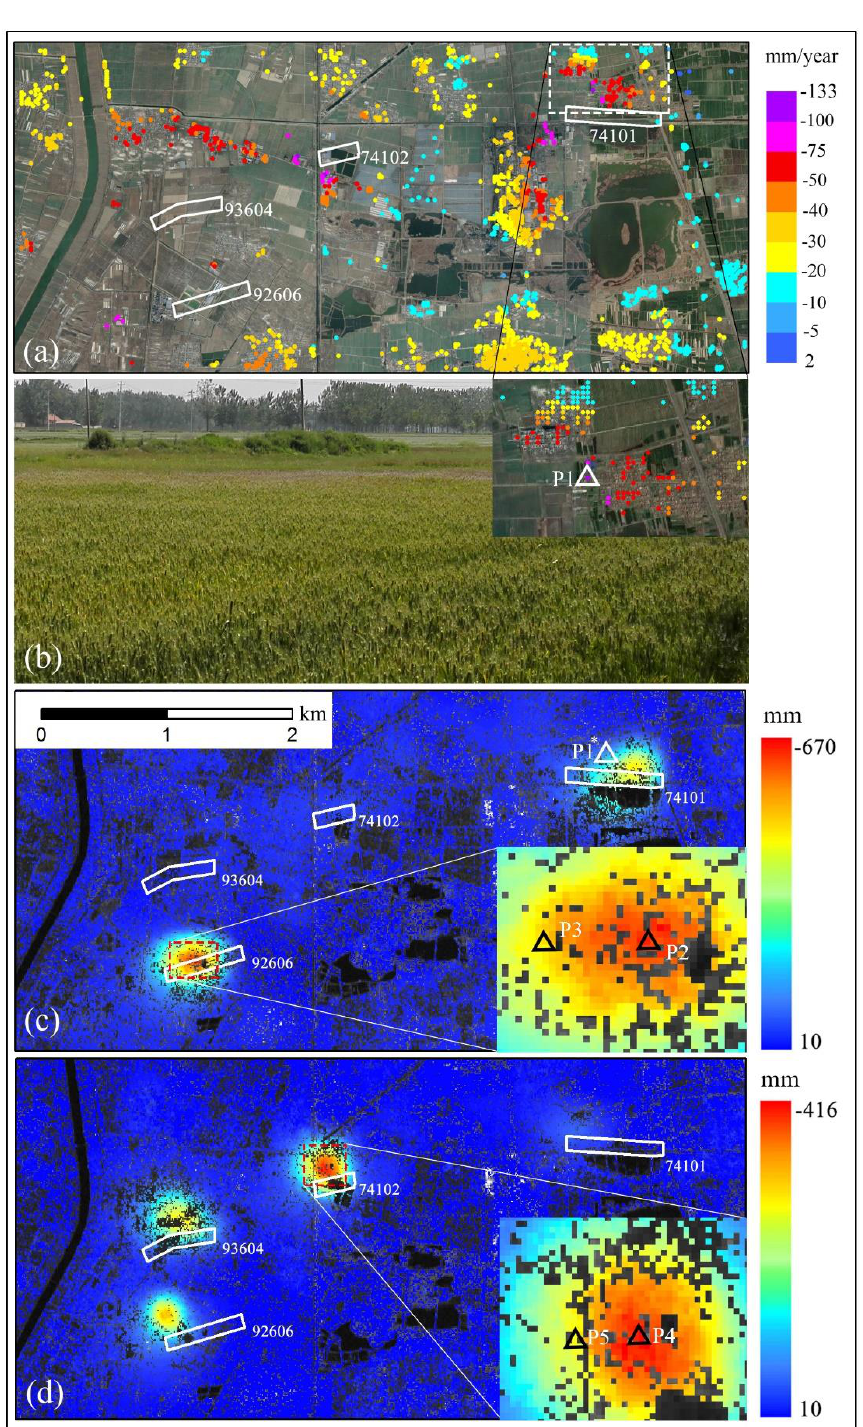
Figure 8. Enlargement of MSV over the rectangle AOI in Figure 7a is shown in ( a ) overlaid on an optical image. The extraction boundary of 4 WPs are also overlaid as white rectangles and polygons in ( a ). The location of a CP (P1) is delineated by the dash-line rectangle in ( a ) with the enlarged view inset. An on-site photo is presented in ( b ) showing winter wheat on the ground above WP 74,101. The accumulative deformation maps for periods of 16 October 2016 to 21 March 2017 and 23 October 2017 to 4 March 2018 are given in ( c , d ) respectively.